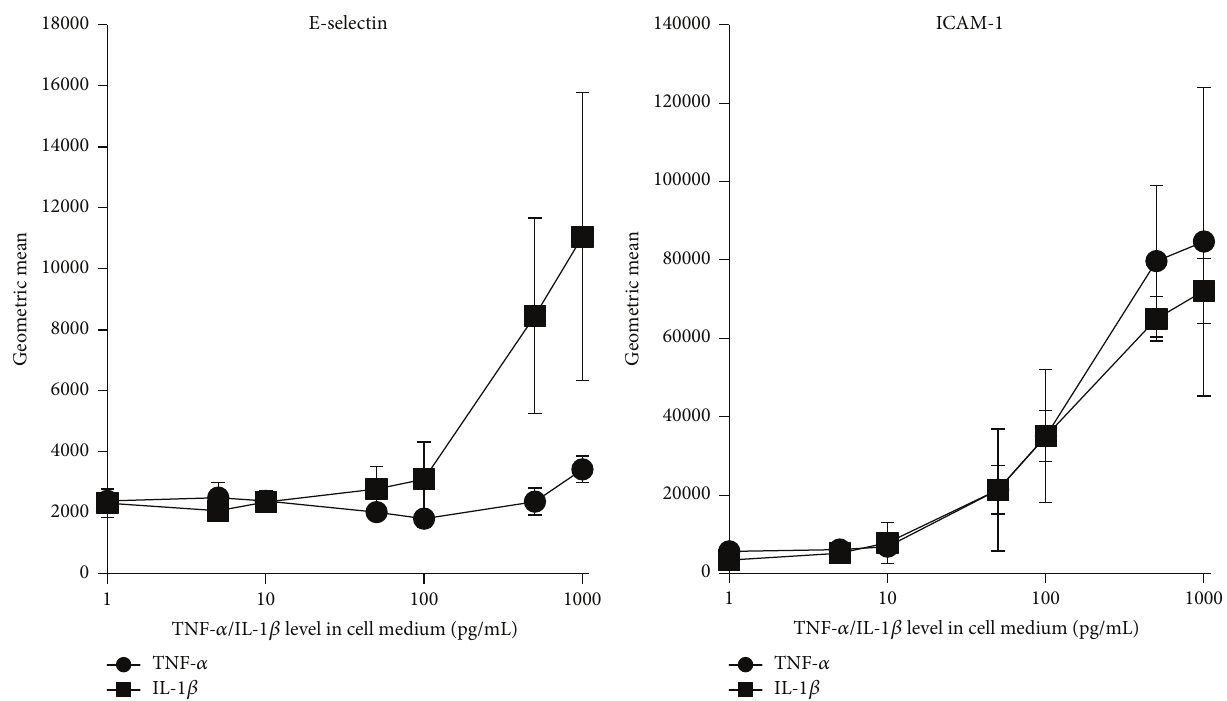
Figure 6: E-selectin and ICAM-1 expression of HUVEC as a function of TNF- 𝛼 or IL-1 𝛽 level. ICAM-1 and E-selectin expression by HUVEC after 16-hour incubation in cell media with 10% of plasma spiked with increasing amounts of TNF- 𝛼 or IL-1 𝛽 (mean ± SD, 𝑛 = 3 ).